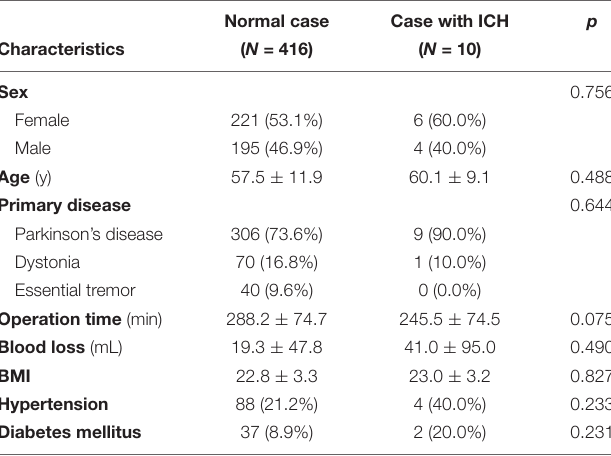
TABLE 3 | Characteristics of patients who developed intracerebral hemorrhage after deep brain stimulation surgery. Normal case Case with ICH p